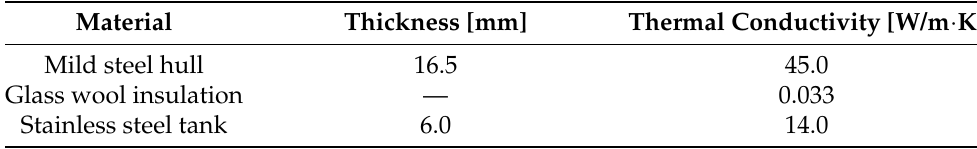
Table A1. The thickness and thermal properties of materials used to model the fuel tank